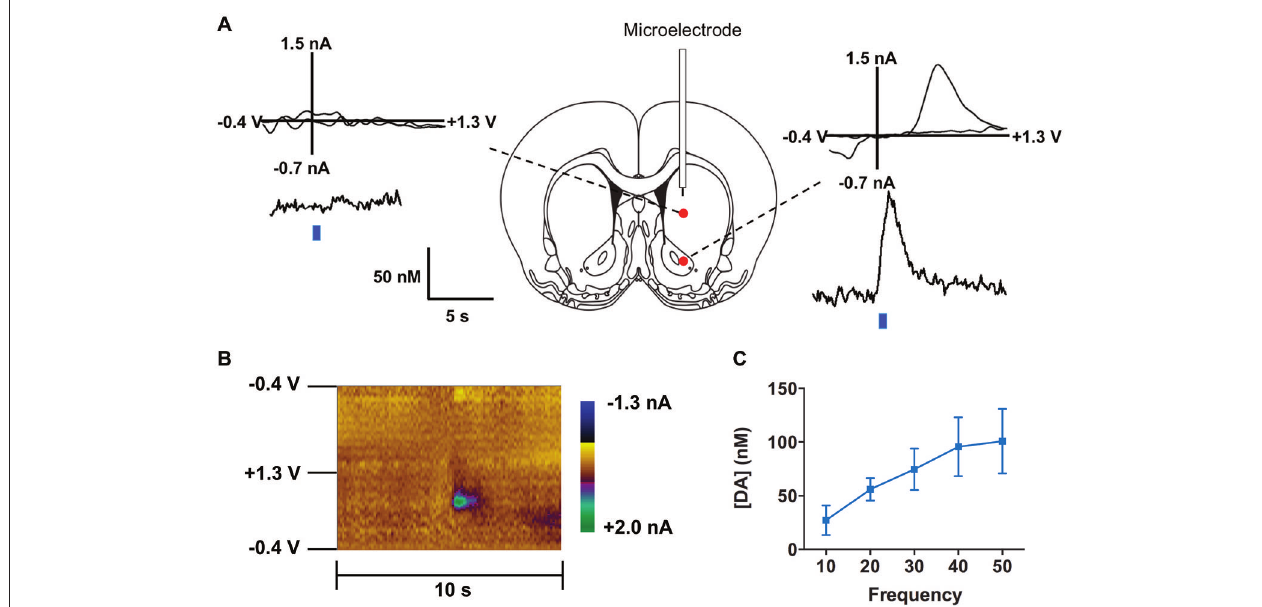
optically-evoked dopamine release measured in real time (left from dorsal striatum, right from ventral striatum, blue line indicates time of light pulse). (B) Standard two dimensional color plot which topographically depicts the voltammetric data with time on the x -axis, applied scan potential on the y -axis and background-subtracted faradaic current shown in the z -axis in pseudo-color. Dopamine can be seen during stimulation at the signature 0.65 V (oxidation peak encoded as green). (C) Magnitude of light evoked dopamine release is frequency